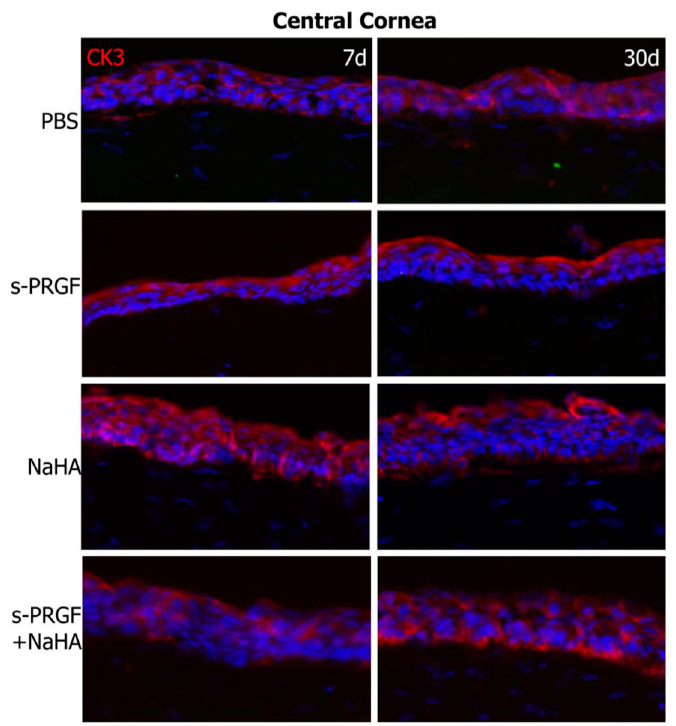
Figure 6. Fluorescent immunostaining for CK3 (red) and CK15 (green) on the regenerated central cornea of rabbit corneas after healing of the epithelial defect. Corneas were treated with s-PRGF, s-PRGF and NaHA, NaHA, or PBS (as a control) and were processed 7 and 30 days after cornea surgery. Control corresponds to a healthy rabbit cornea with no surgery. The W-H image shows a cornea processed 48 h after surgery without complete re-epithelialization. Magnification 200 ×